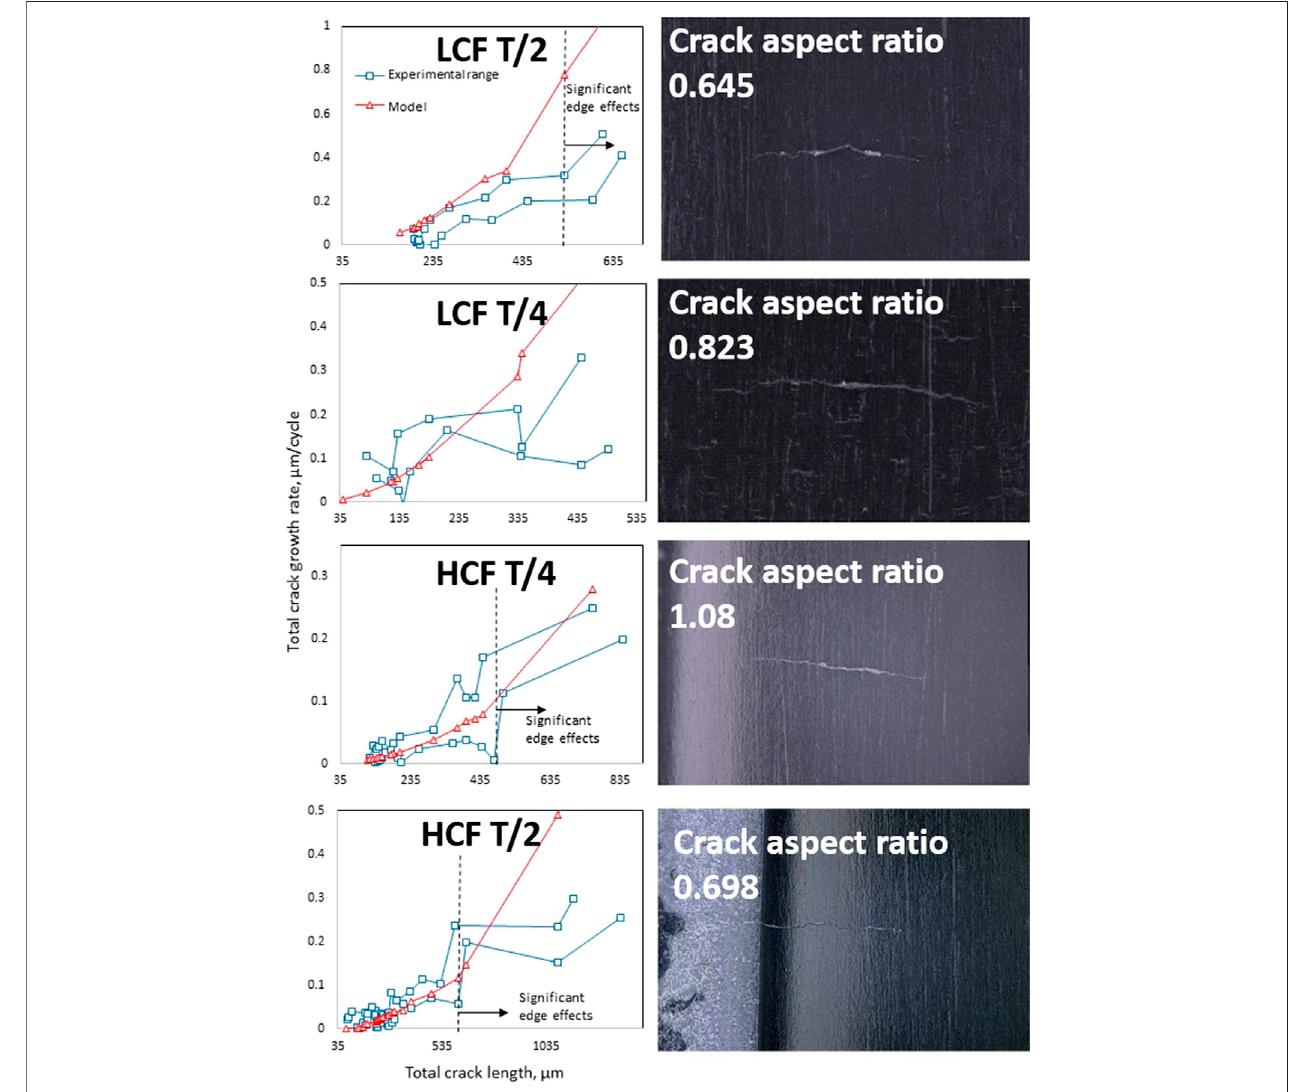
FIGURE8| Modelpredictionsvs.experimentalcrackgrowthforthe (A) LCFt/2, (B) LCFt/4, (C) HCFt/4,and (D) HCFt/2.Theredlineshowsthepredictedvalueof crackgrowthateach cracklength,and thegreenlinesshowthehighandlowestimatesofexperimental crackgrowth.Theverticalbluelineshowstheracklengthwhere signi fi cant edge effects